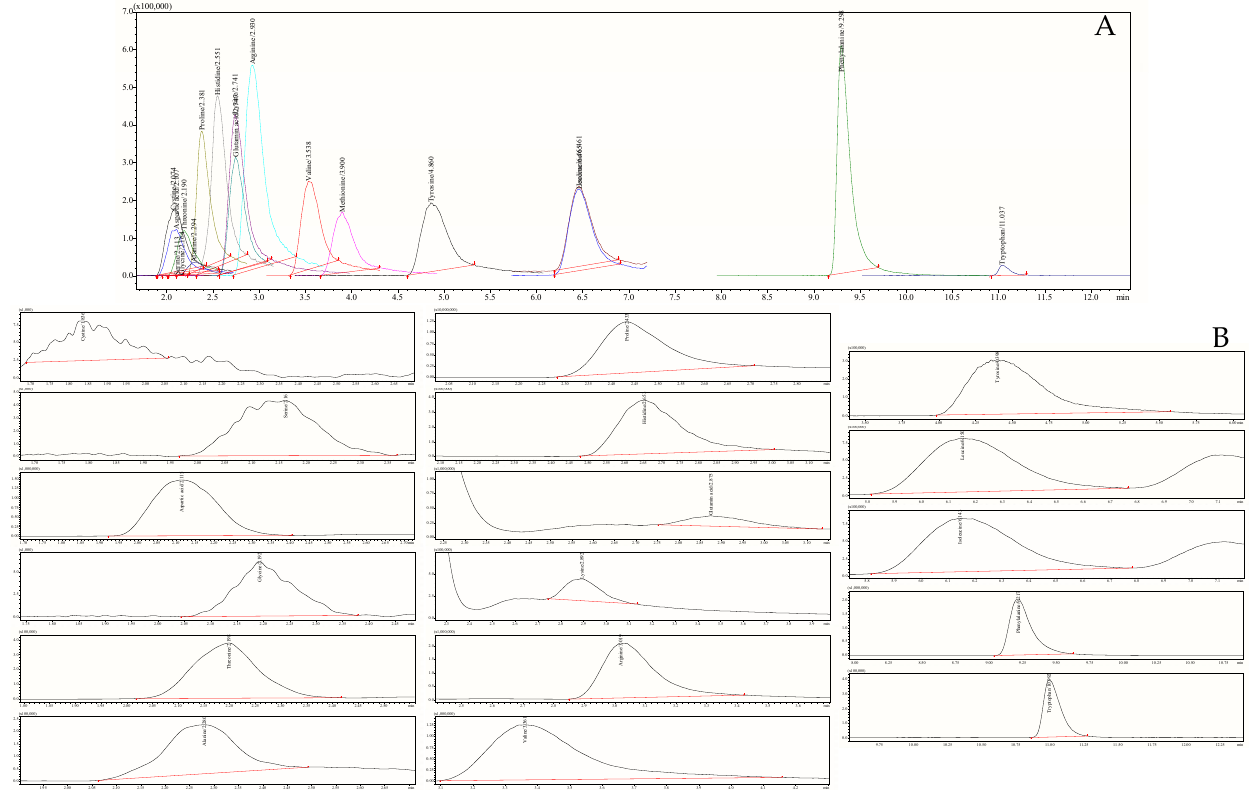
Figure 2. Total ion current (TIC) chromatograms in MRM mode are given for 18 amino acid standards at the concentration of 0.078 µM L −1 ( A ) and honey sample ( B ). Samples injection volume 3.0 uL (0.003 ug mL −1 ).